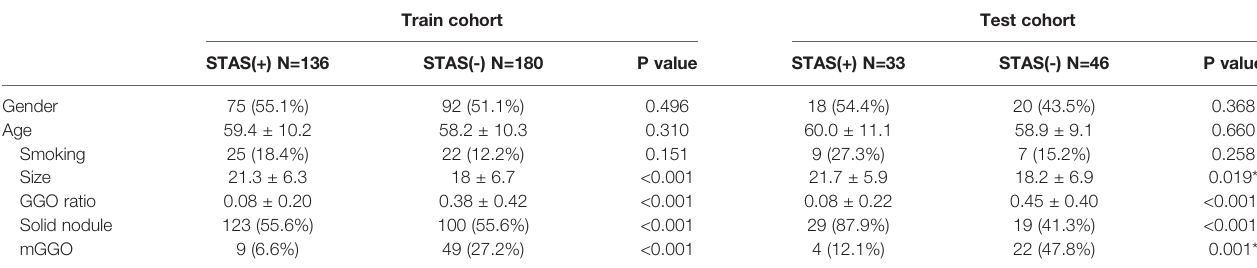
Solid nodule 123 (55.6%) 100 (55.6%) <0.001 <0.001* mGGO